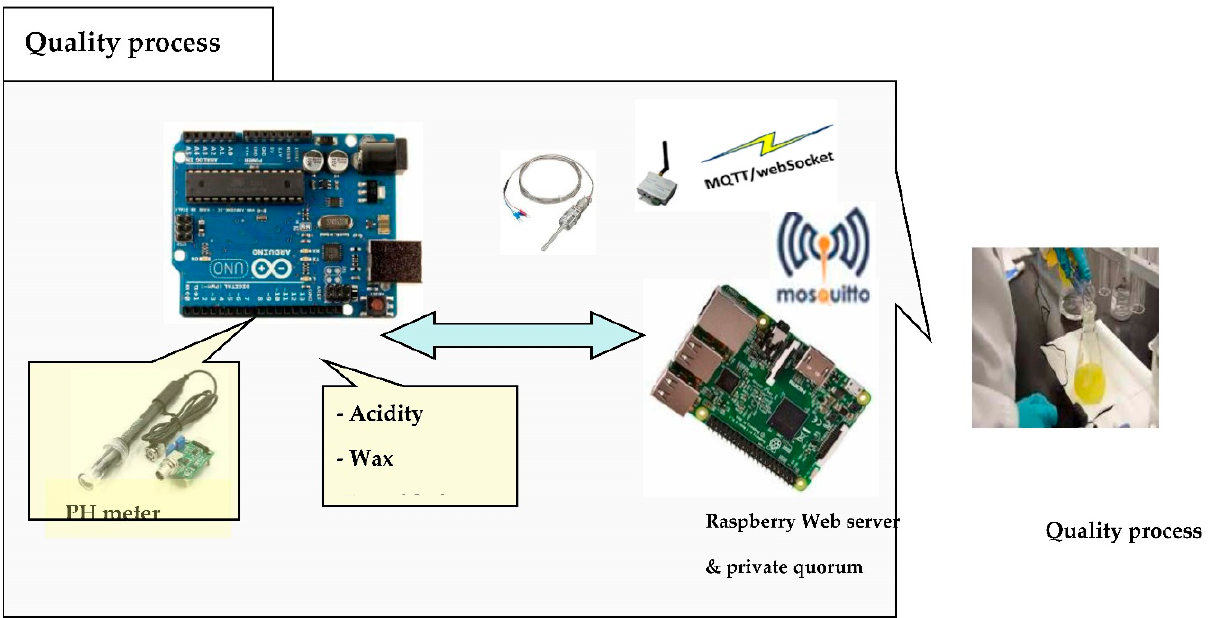
Figure 8. Quality process platform.